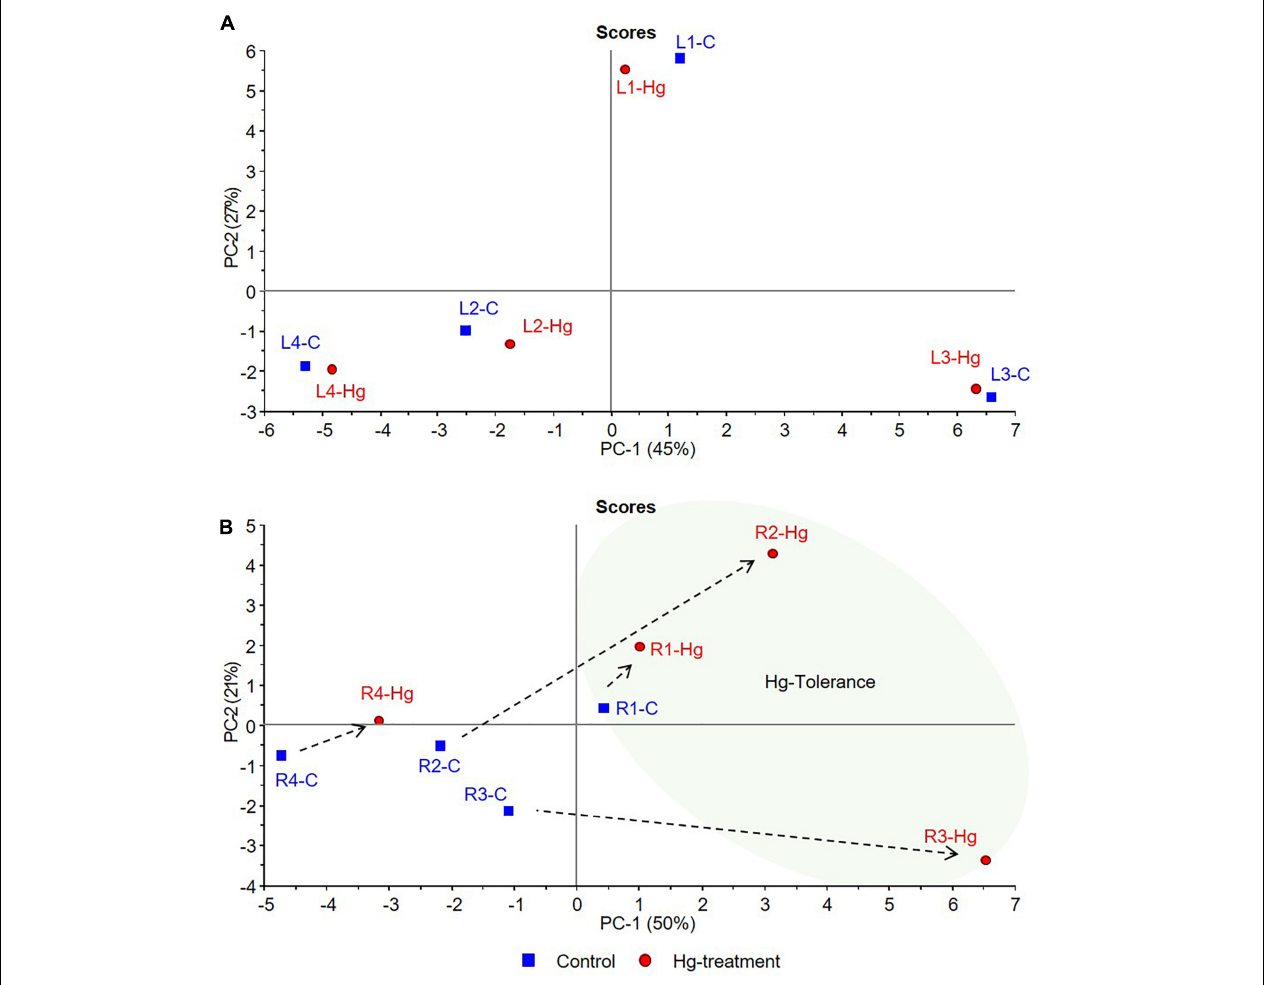
FIGURE 7 | PCA score plots of control (C, blue) and Hg-treated varieties (Hg, red) of Medicago truncatula, based on individual flavonoid accumulation. (A) Leaves and (B)